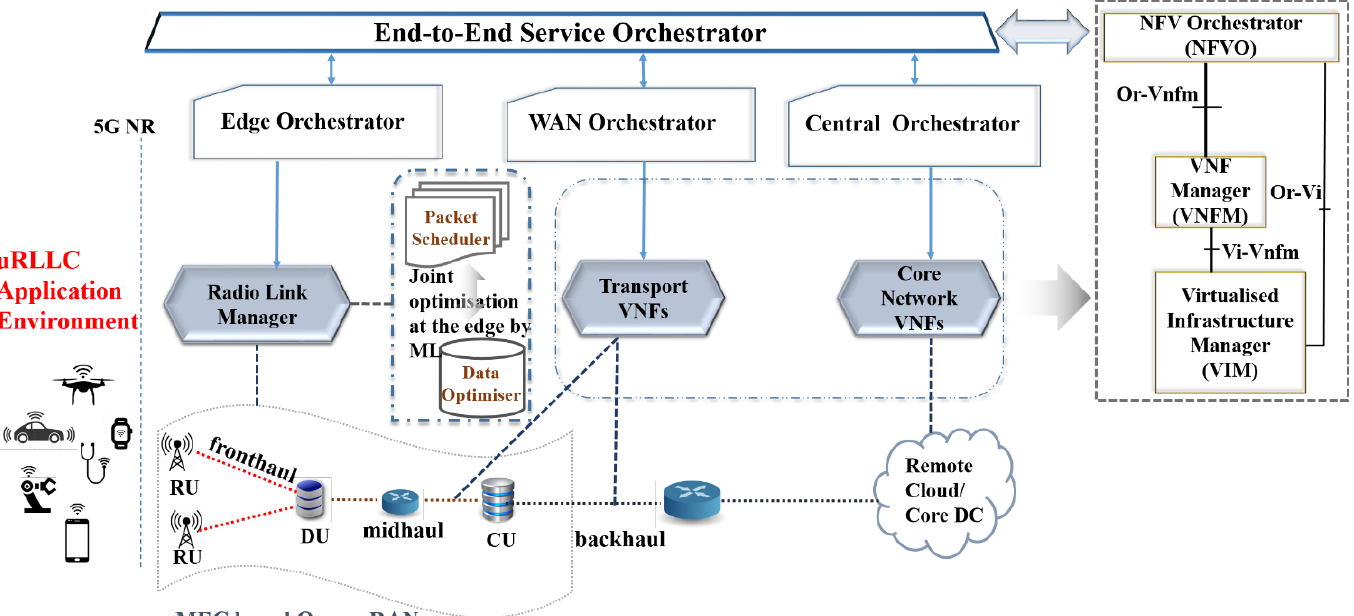
EAI Endorsed Transactions